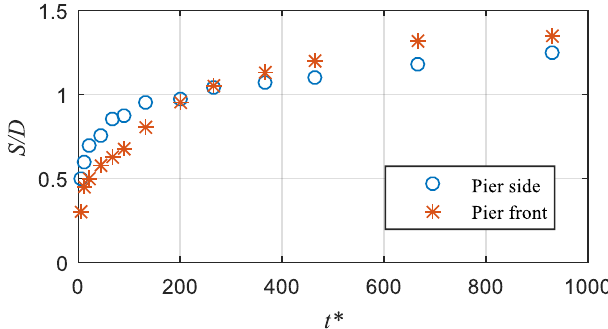
Figure 5. Measured scour depths versus time at the front and side faces of the pier.